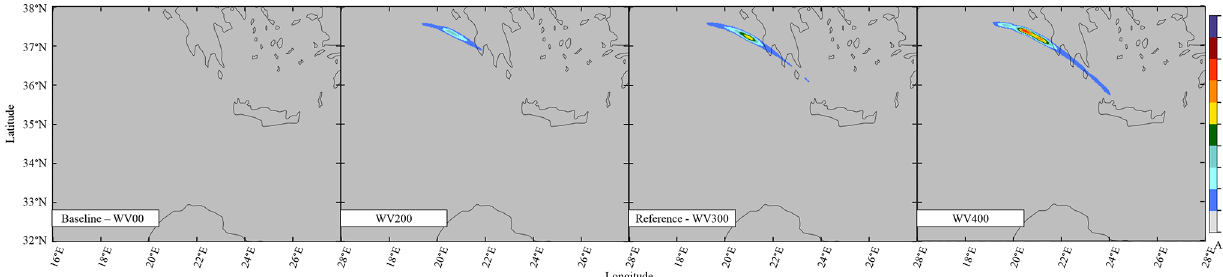
Figure 4. The CHIMERE-modelled 200nm AOD from volcanic